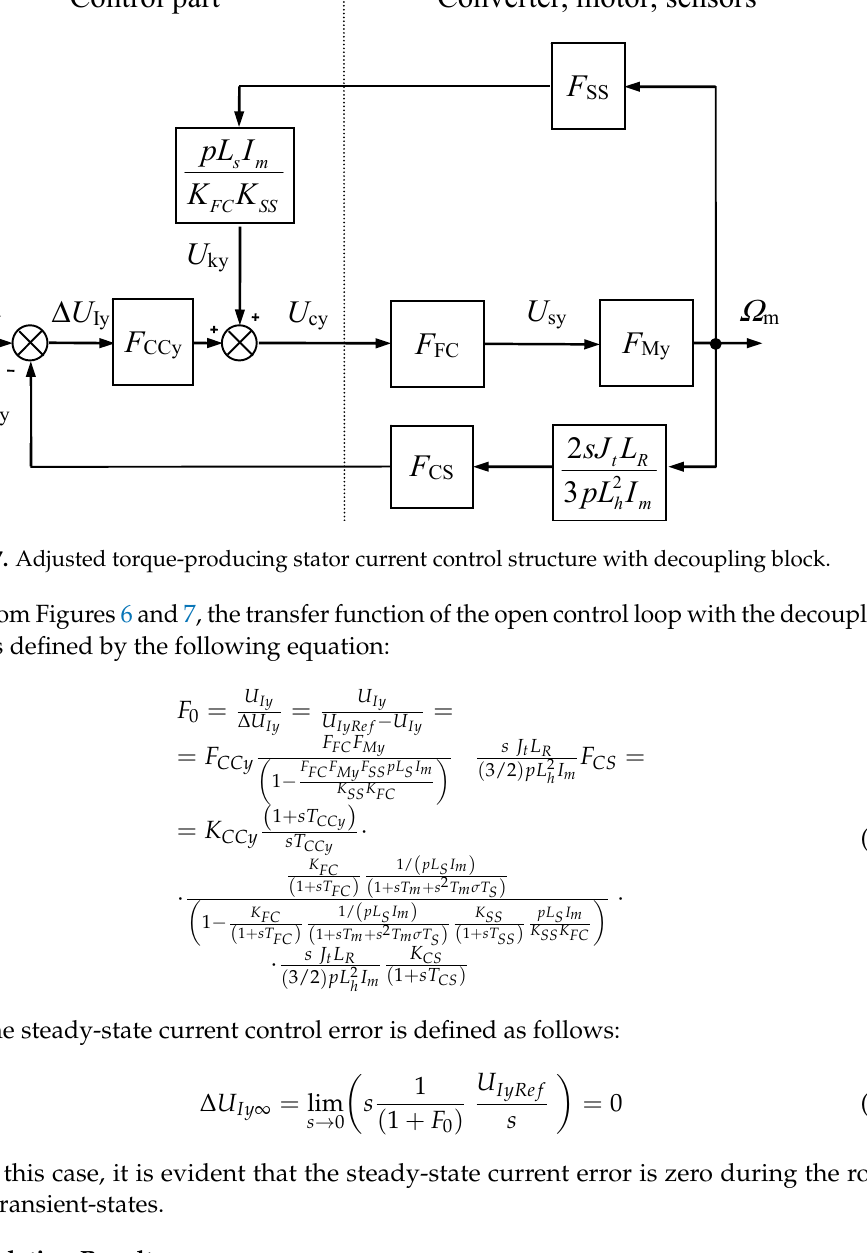
Figure 6. Torque-producing stator current control structure with decoupling block.